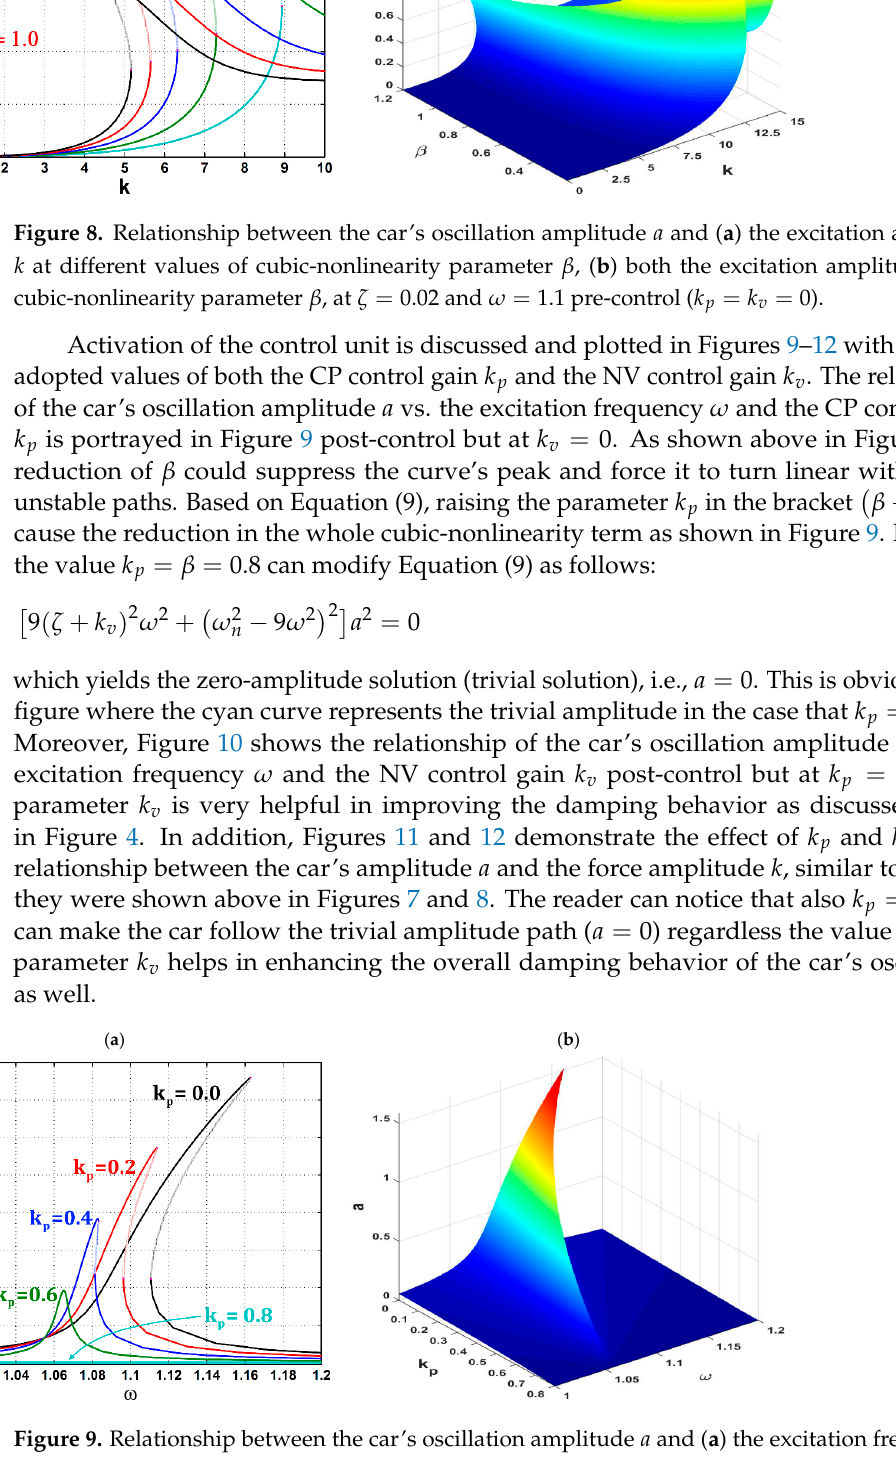
Figure 10. Relationship between the car’s oscillation amplitude (cid:1853) and ( a ) the excitation frequency (cid:2033) at different values of NV control gain (cid:1863) (cid:3049) , ( b ) both the excitation frequency (cid:2033) and NV control gain (cid:1863) (cid:3049) post-control ( (cid:1863) (cid:3043) = 0.6 ).